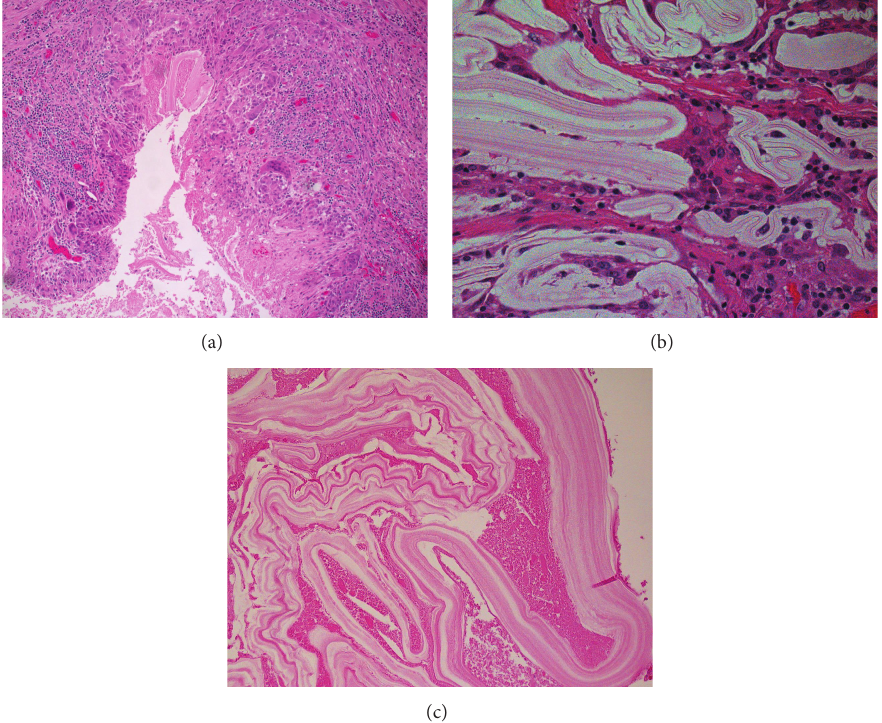
Figure 2: (a) A palisade of granulomatous reaction around membranous structures. (b) High power magnification displaying the laminated membranous structures eliciting an inflammatory response within the cyst wall. (c) High power magnification displaying the laminated characteristic of Echinococcus cyst